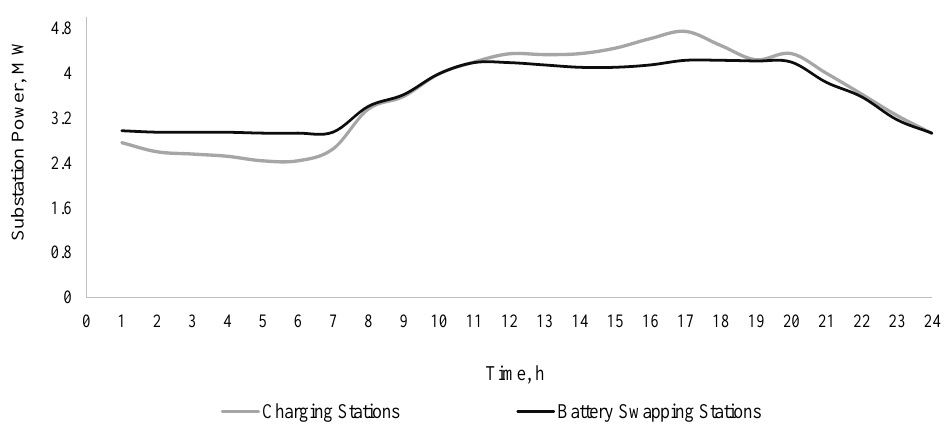
Figure 8. The power of the distribution substation at location 1 with charging and battery- swapping stations.